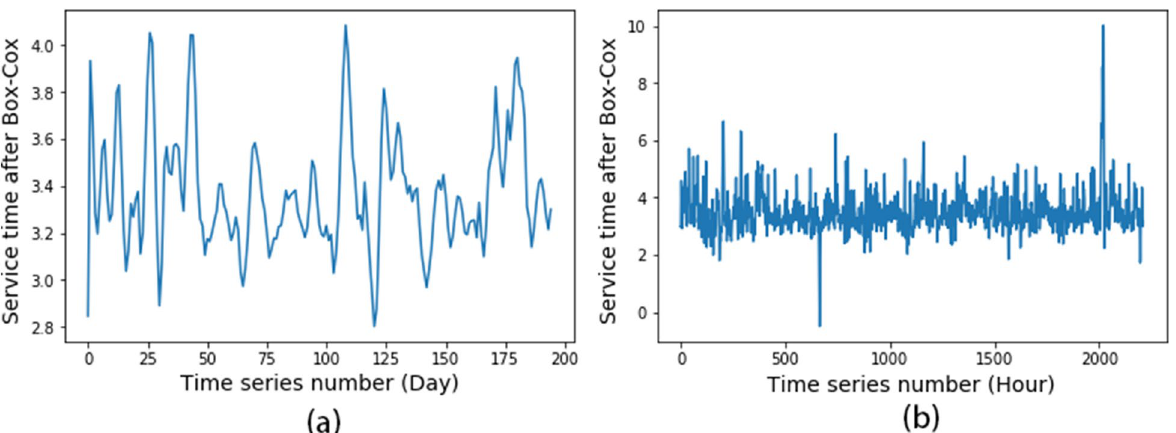
Fig. 1 Box-Cox conversion values of the average response time of layer action a at a time granularity of 1 day and b at a time granularity of 1 hour